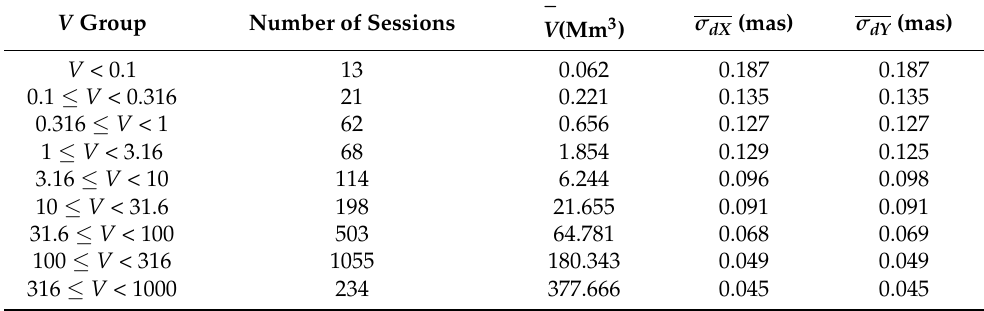
Table 4. Average network volume, number of sessions and CPO uncertainties per volume